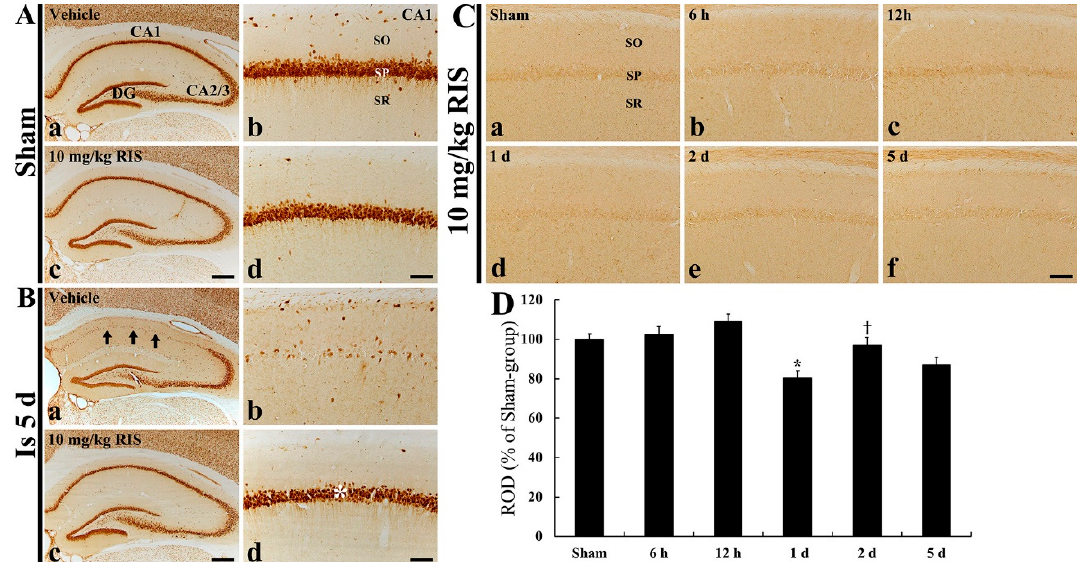
Figure 8. ( A – C ) Immunohistochemistry for NeuN ( A , B ) and CD200 ( C ) in the hippocampus ( Aa , Ac , Ba and Bc ) and CA1 field ( Ab , Ad , Bb , Bd and Ca – Cf ) of the sham/vehicle ( Aa , Ab and Ca ), sham/RIS ( Ac , Ad and Ca ), ischemia/vehicle ( Ba , Bb ), and ischemia/RIS ( Bc , Bd and Cb – Cf ) groups at 5 days after tFI. tNeuN immunoreactive CA1 pyramidal neurons are rarely found in the SP of the CA1 field. However, in the ischemia/RIS group, CA1 pyramidal neurons (asterisk) show strong NeuN immunoreactivity. CD200 immunoreactivity is transiently reduced at 1 day after tFI. Scale bar = 400 µm ( Aa , Ac , Ba and Bc ) and 50 µm ( Ab , Ad , Bb , Bd and C ). ( D ) ROD as % of CD200-immunoreactive structures in the CA1 field ( n = 5 at each time; * p < 0.05, significantly different from sham/group; † p < 0.05, significantly different from pre-time point group). Bars indicate the means ± SEM.